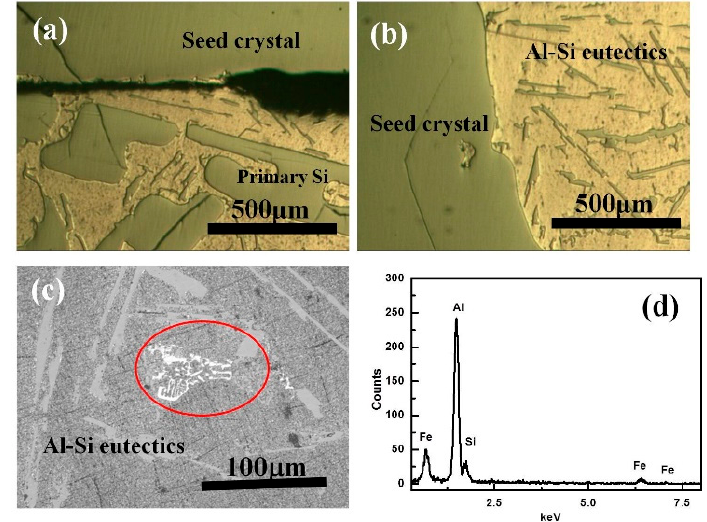
Figure 3. Microstructures of interface in the PUA sample in Al–25%Si alloy ( a ) boundary at the bottom; ( b ) boundary at the lateral side; ( c ) impurities in the PUA sample; ( d ) EDS analyses spectra of impurity phase in the red circle.